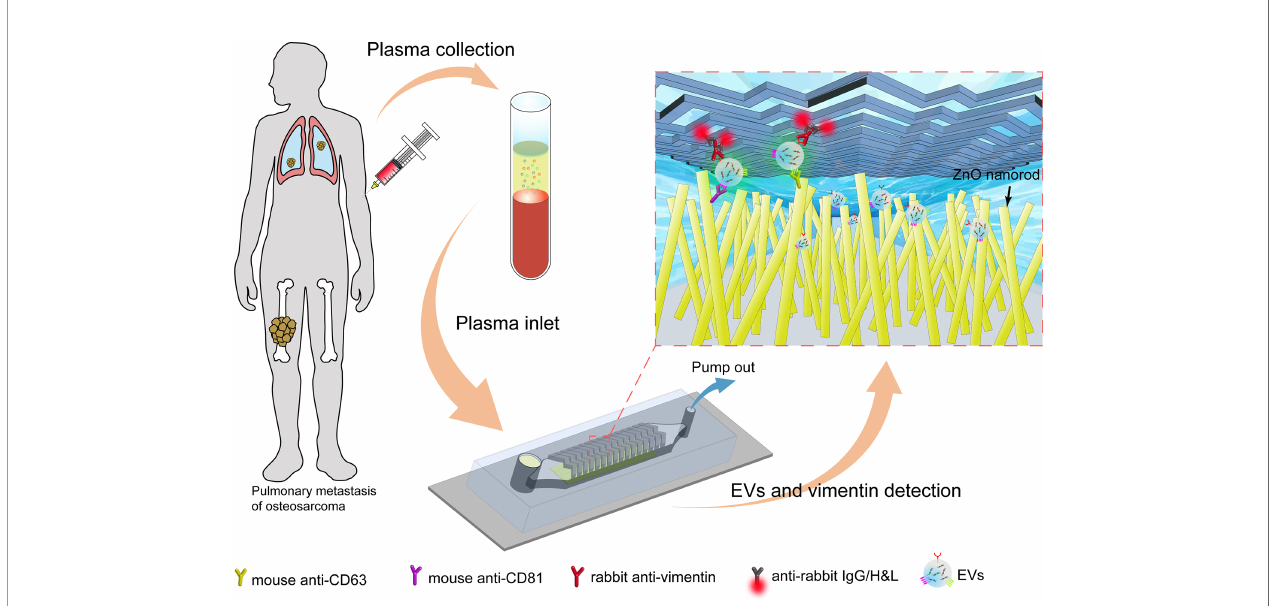
FIGURE 1 | The overall process fl ow of the ZnO nanorods integrated (ZNI) micro fl uidic chip for detection of EVs from osteosarcoma patients. First, the peripheral blood of osteosarcoma patients was collected, and the blood cells and plasma were separated by centrifugation. At the other end of the chip, a syringe pump was used to pump the plasma in the sample reservoir at a fi xed speed to capture EVs in the plasma. Next, the lipophilic membrane dye 3,3 ’ -dioctadecyloxacarbocyanine (DiO) was used to quantify the captured EVs in the chip. Finally, EV membrane vimentin (VIM, a sarcoma biomarker) was detected using a second signal based on fl uorescence conjugated antibodies.